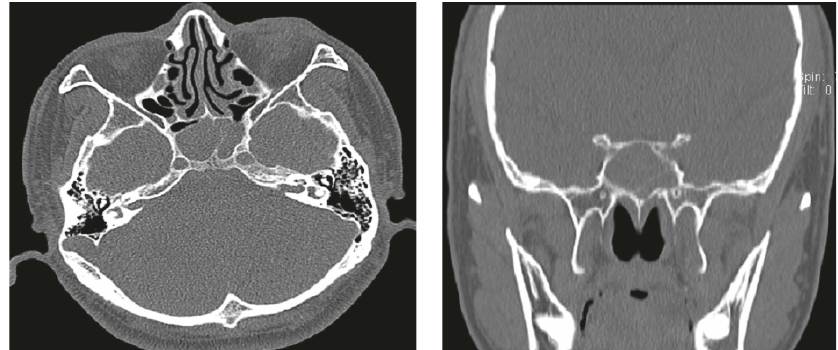
Figure 1: CT scan showed soft-tissue density neoplasms filling with sphenoidal sinus.